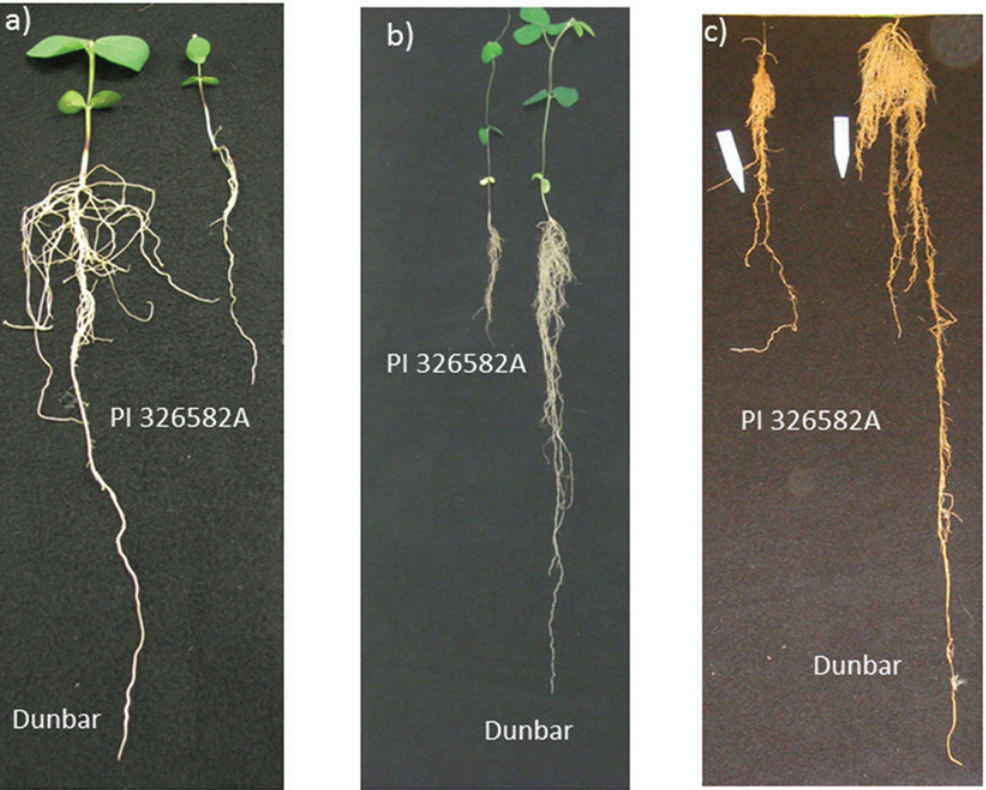
Fig 2. Root architecture contrasts between the two parents at: a) 12 days; b) 21 days; and c) 35 days after